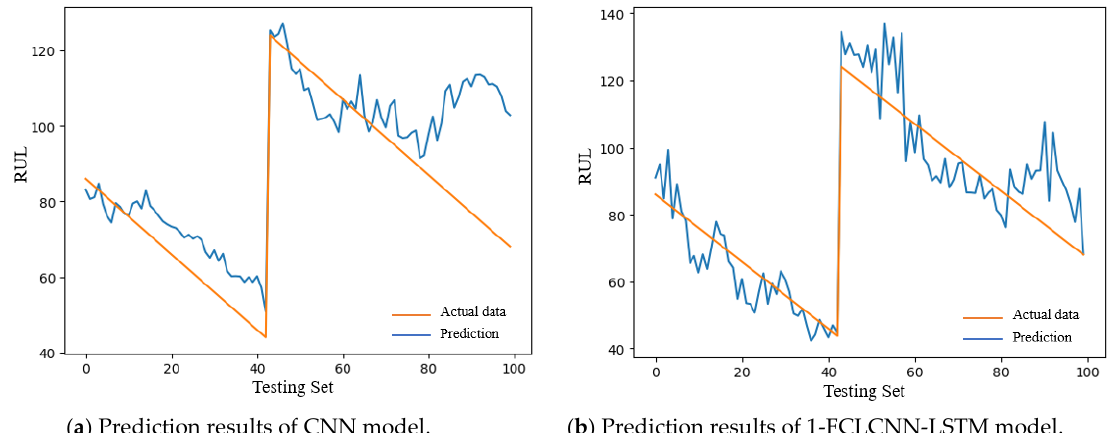
Figure 15. RUL prediction results of FD003 with different models.